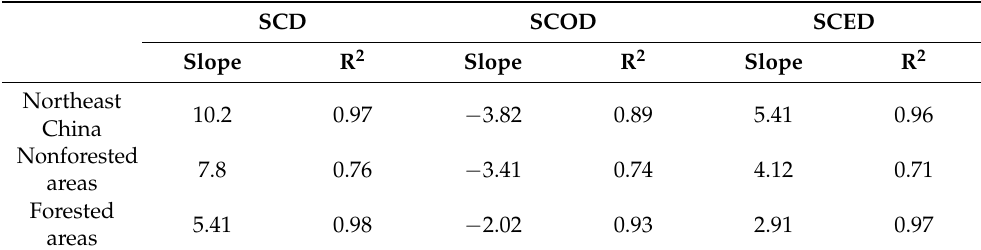
Table 4. Linear slope and R 2 of the mean SCD, SCOD, and SCED with latitudes from 39.22 ◦ N to 53.22 ◦ N in the nonforested and forested areas in Northeast China. SCD